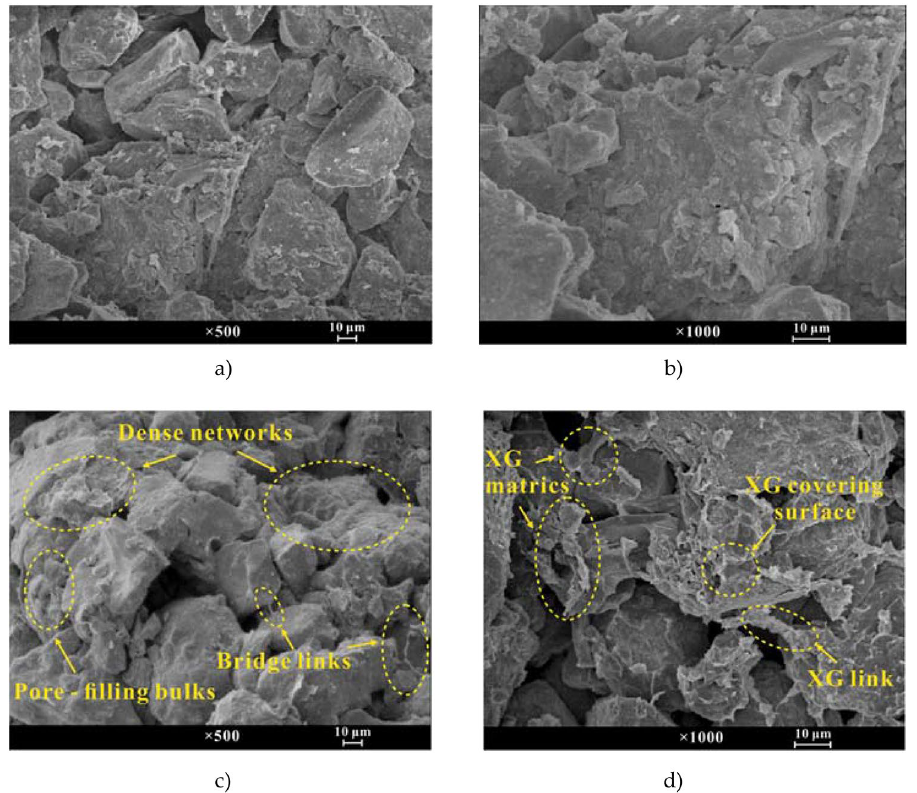
Figure 4. ( a ) SEM image of untreated soil at × 500; ( b ) SEM image of untreated soil at × 1000; ( c ) SEM image of the 2.0% XG-treated soil at × 500; ( d ) SEM image of the 2.0% XG-treated soil at × 1000.